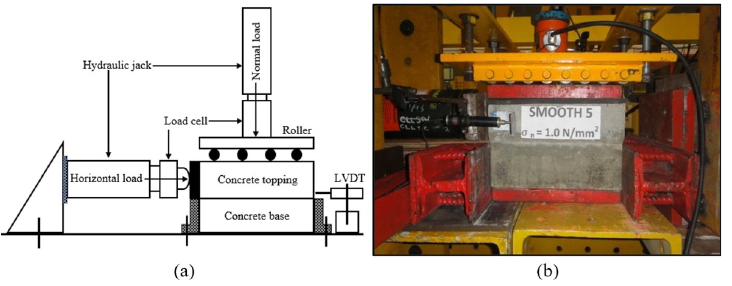
Fig 3. “Push-off” test setup: a) Schematic drawing, and b) Experimental